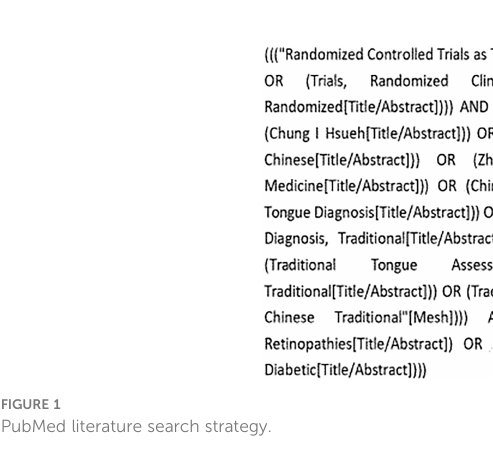
FIGURE 1 PubMed literature search